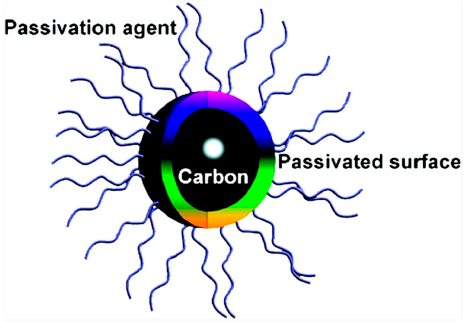
Figure 1. Schematic illustration of the structure of C-dots. Reproduced with permission from [19]. Copyright (2010) American Chemical Society.